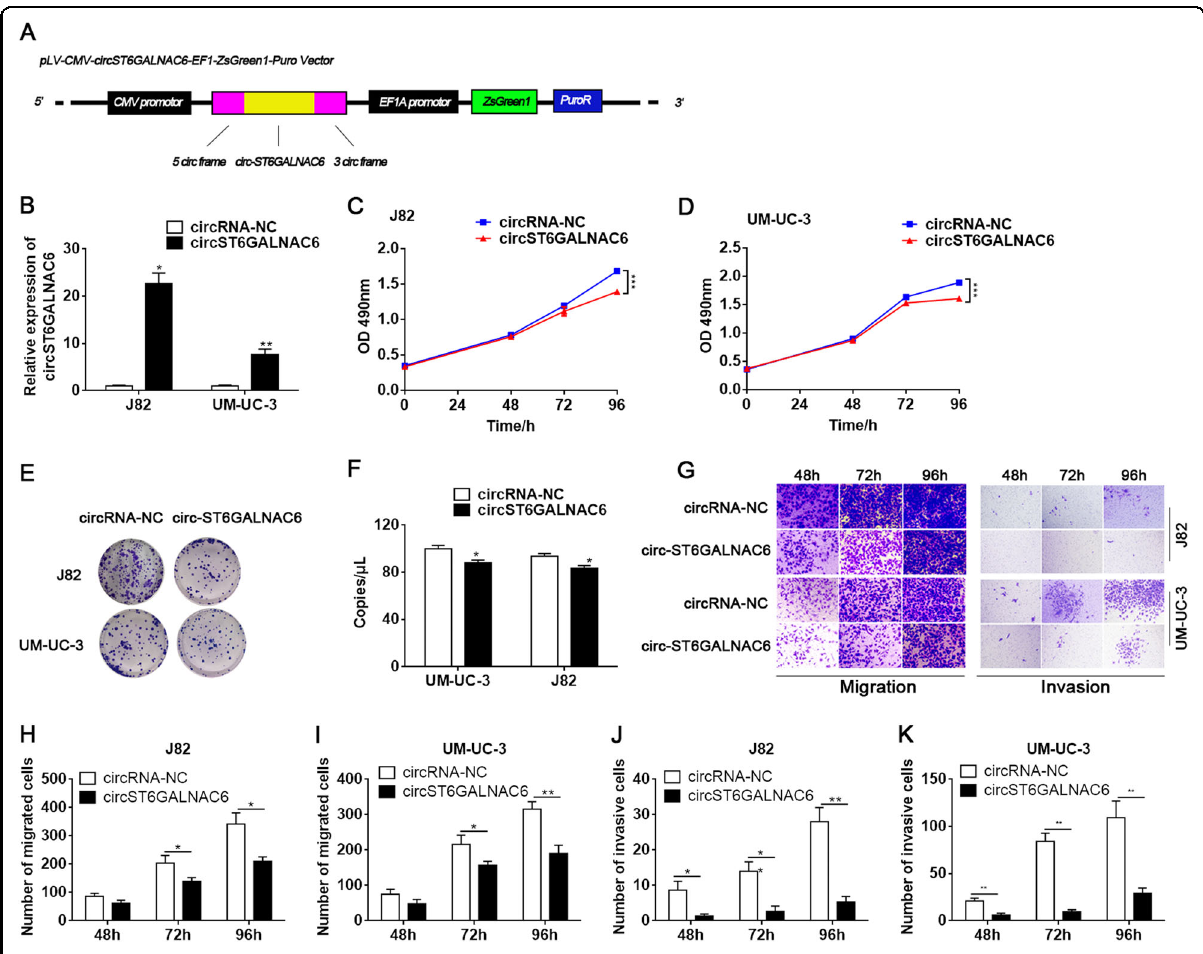
Fig. 2 Overexpression of circST6GALNAC6 inhibited the proliferation, migration and invasion of bladder cancer cells. A Schematic representation of the plasmid overexpressing circST6GALNAC6. B Relative circST6GALNAC6 levels in cells transfected with circRNA-NC or circST6GALNAC6 were detected by qRT-PCR. C , D MTT assay to measure the cell viability of cancer cells transfected with circRNA-NC or circST6GALNAC6. E , F Cell proliferation abilities were detected by colony formation assays in transfected J82 and UM-UC-3 cells. G – K Cell migration and invasion abilities were measured with Transwell assays. *** P < 0.001, ** P < 0.01 and * P <